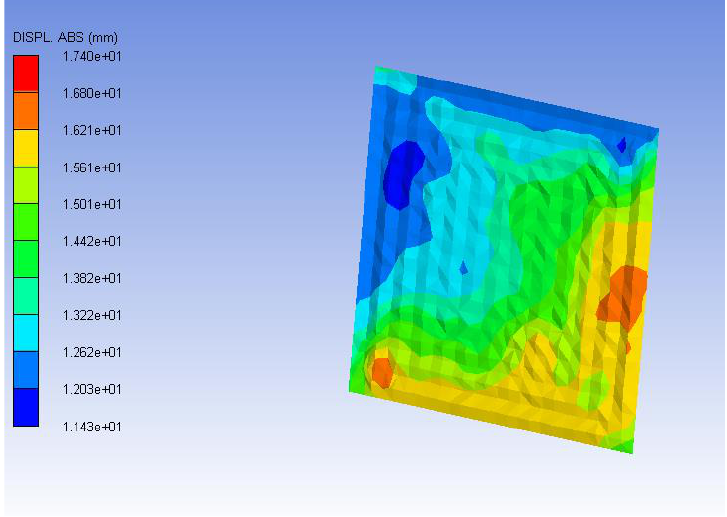
Figure 10. Numerical displacement distribution.